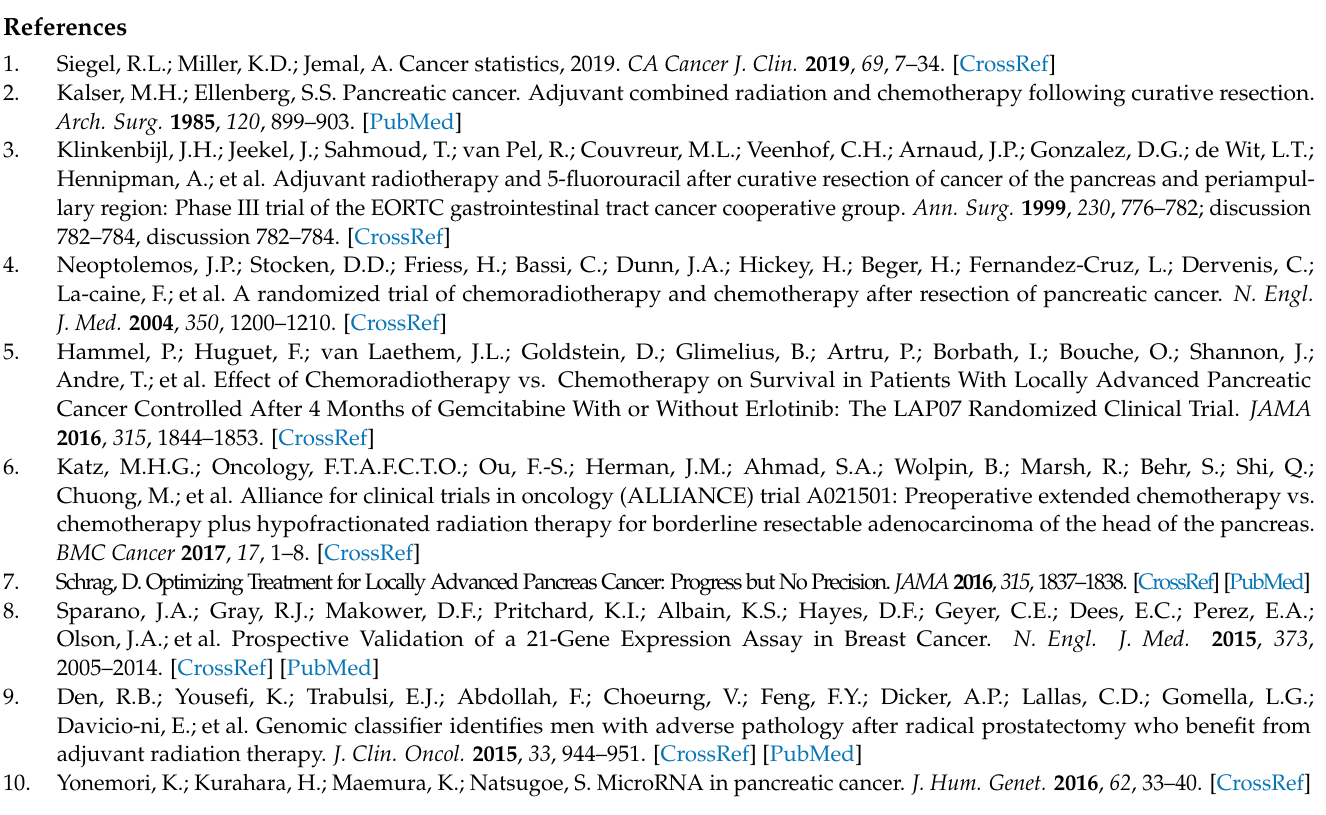
Table S4: Multivariable analysis for locoregional recurrence of patients with borderline resectable or locally advanced pancreatic